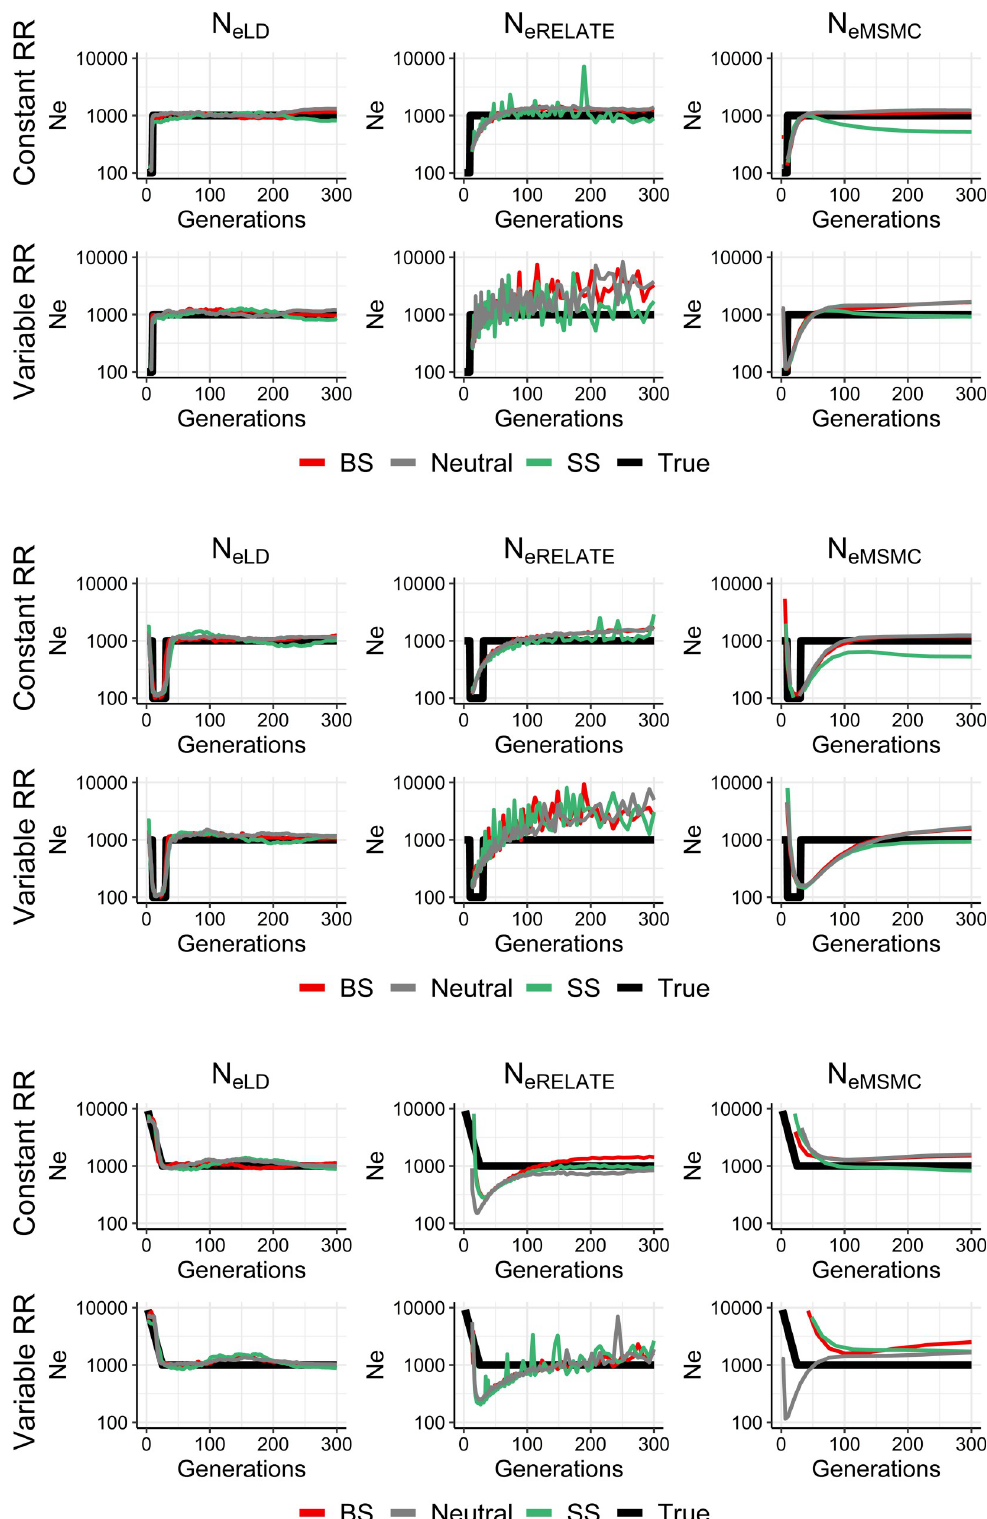
Fig 3. Estimates of historical effective population size from linkage disequilibrium ( N eLD , sample size n = 100 individuals), Relate ( N , n = 100) and MSMC ( N , n = 4) from the present generation (generation 0) back eRelate eMSMC